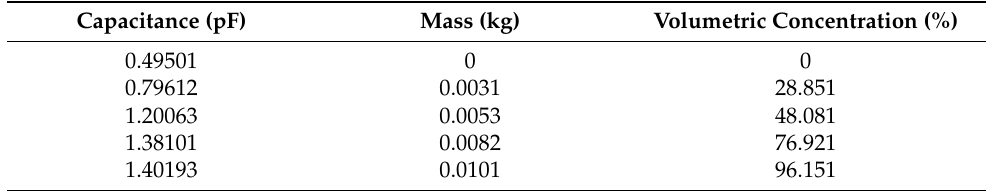
Table 3. Calibration parameters for average capacitance and volumetric concentration.